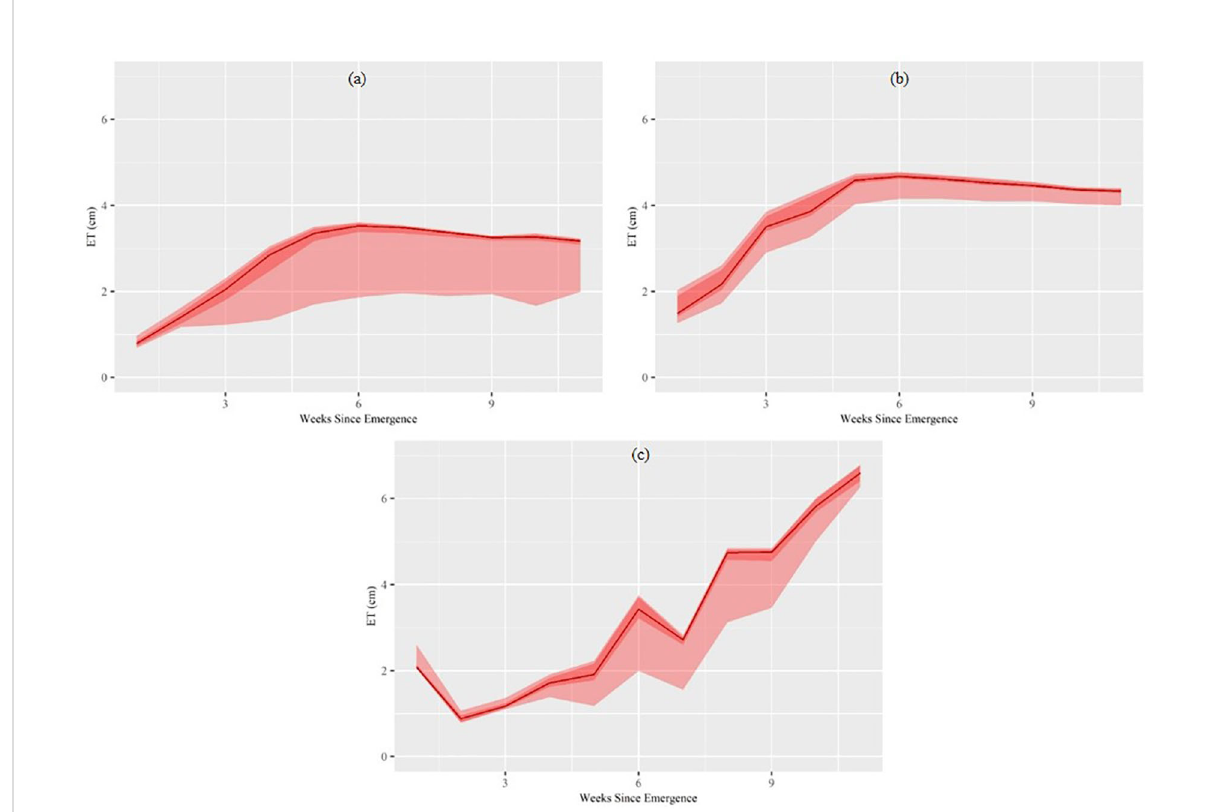
FIGURE 8 Mean, middle 90th percentile (dark red), and range (light red) of weekly evapotranspiration for all variable speed zones in (A) Field A, (B) Field B and (C) the SWREC Pivot.